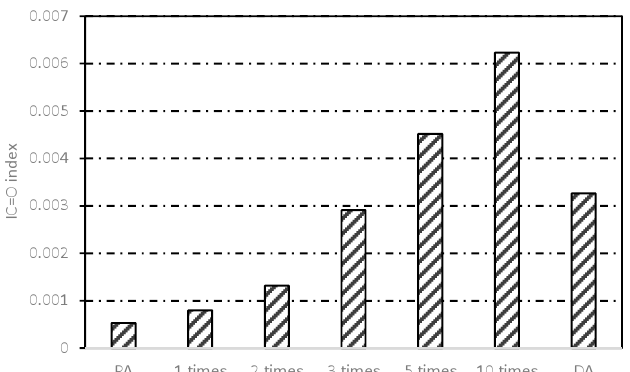
Figure 15. I C=O variation of asphalt binders before and after induction heating.